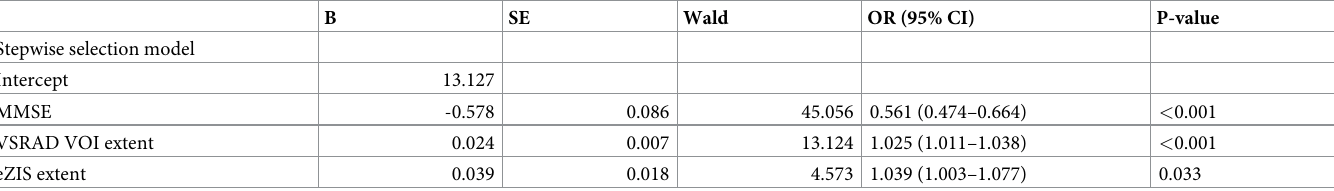
Table 2. Results of the binomial logistic regression analyses.